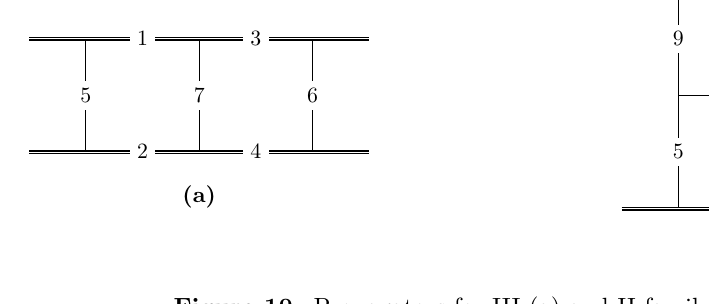
Figure 10. Propagators for III (a) and H family